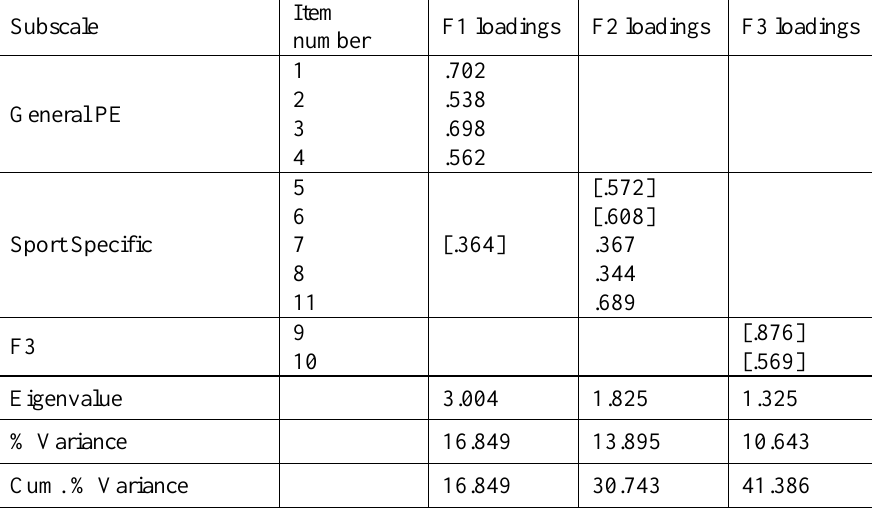
Principal components factor loadings for CAIPE-R items (n=174)